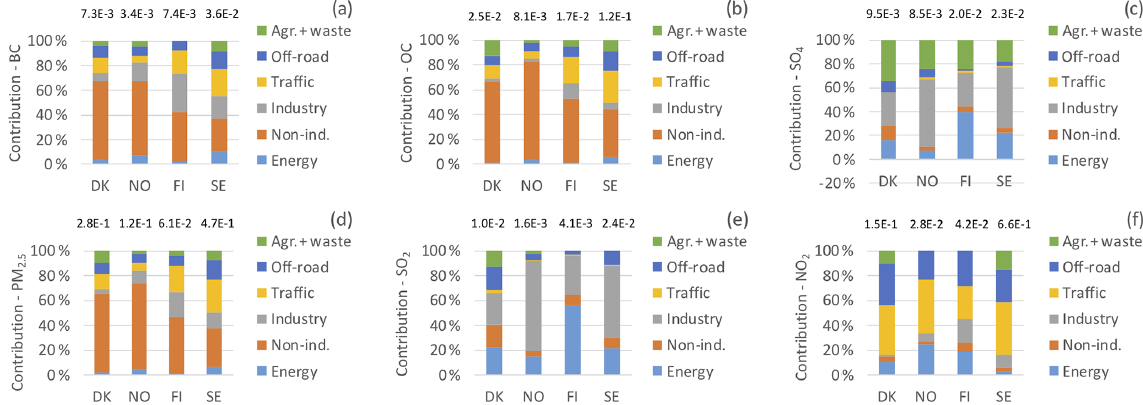
Figure 9. Population-weighted sectoral contributions of Swedish emissions on surface (a) BC, (b) SO 4 , (c) OC, (d) PM 2 . 5 , (e) SO 2 and (f) NO 2 over the Nordic countries. The labels above the bars show the absolute total contribution in µgm − 3 from all the sectors in Sweden.